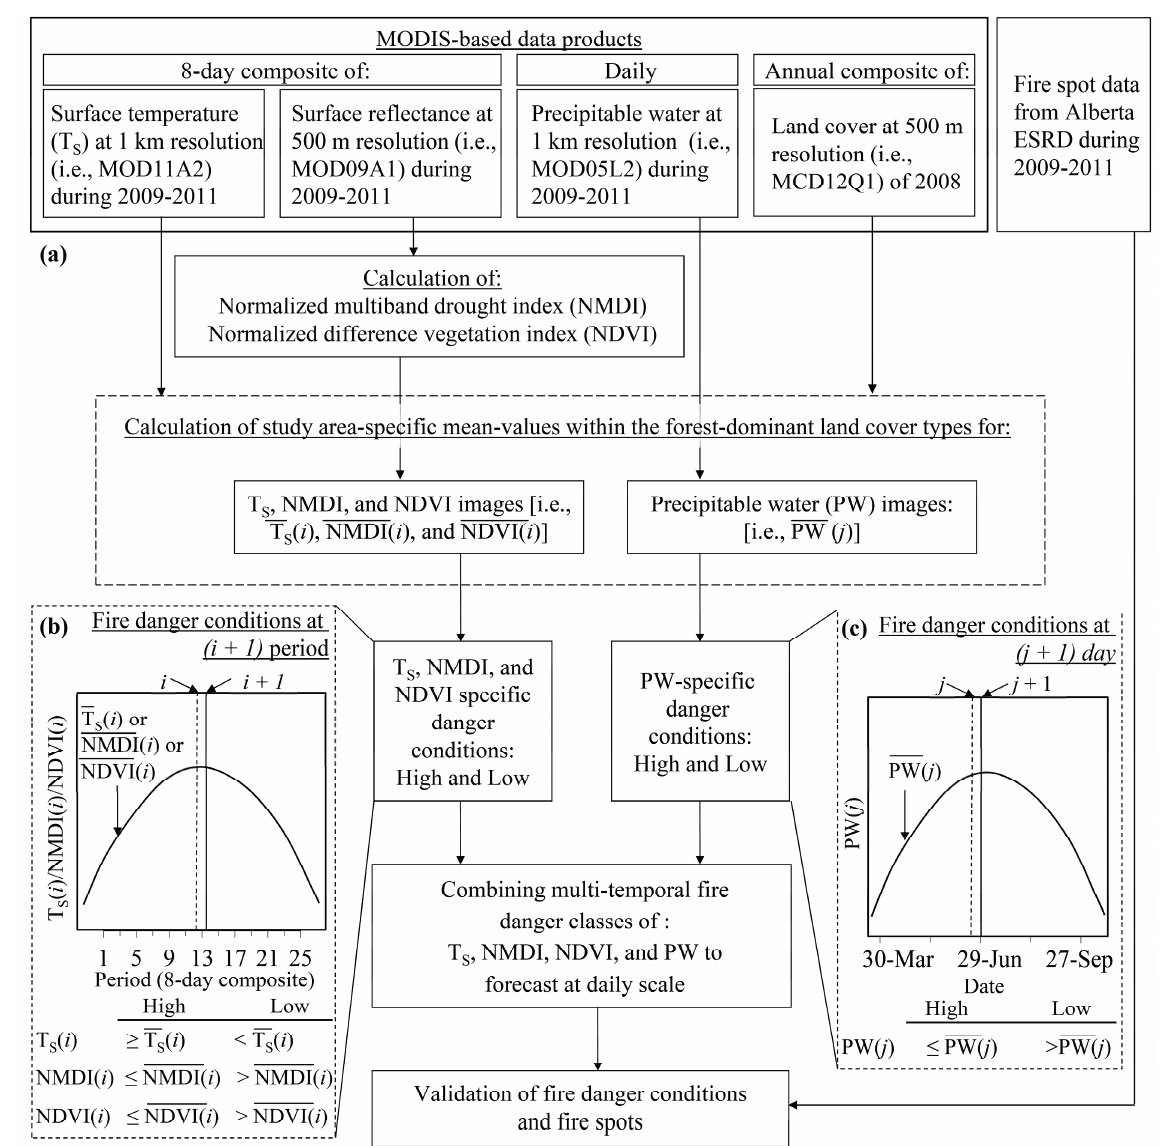
Figure 2. ( a ) The conceptual diagram of daily-scale FFDFS; ( b ) fire danger conditions of 8-day scale T S , NMDI, and NDVI (based on Chowdhury and Hassan [42]); and ( c ) fire danger conditions of daily